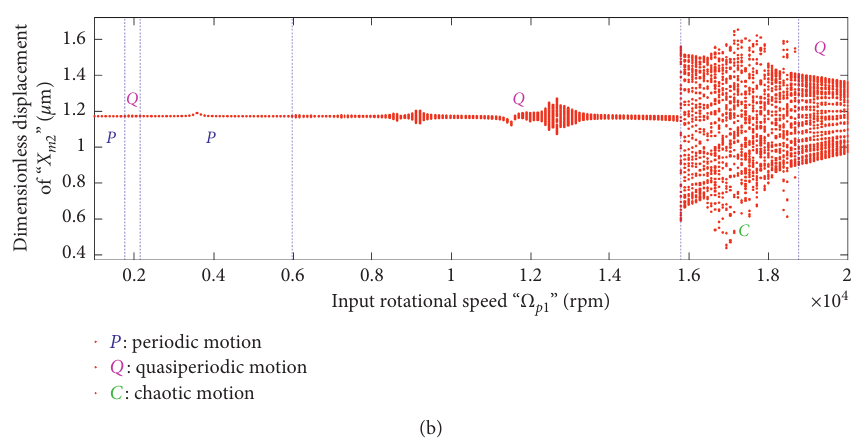
Figure 17: Backward bifurcation diagrams of system; s